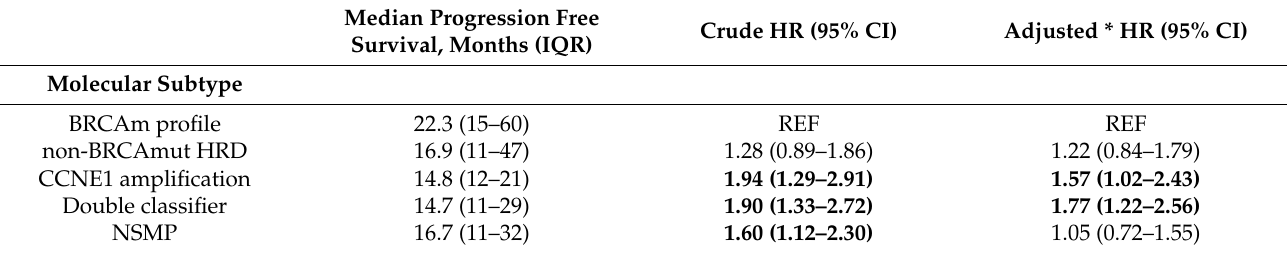
Table 3. Progression-free survival analysis, molecular